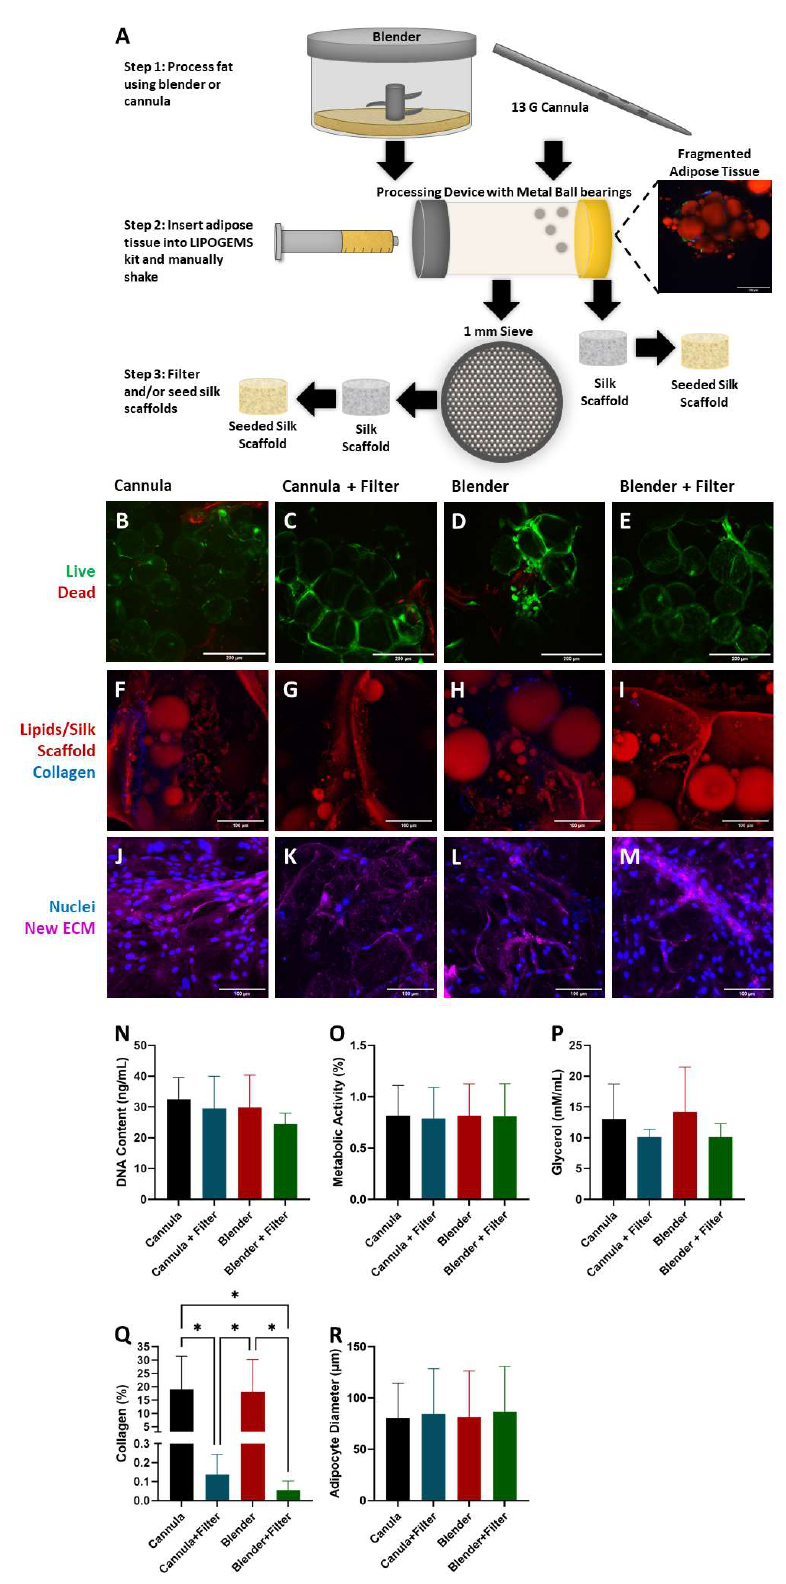
Figure 1. There were no significant differences in adipocyte viability, morphology, or function between the examined tissue processing techniques (blender + LIPOGEMS, cannula +